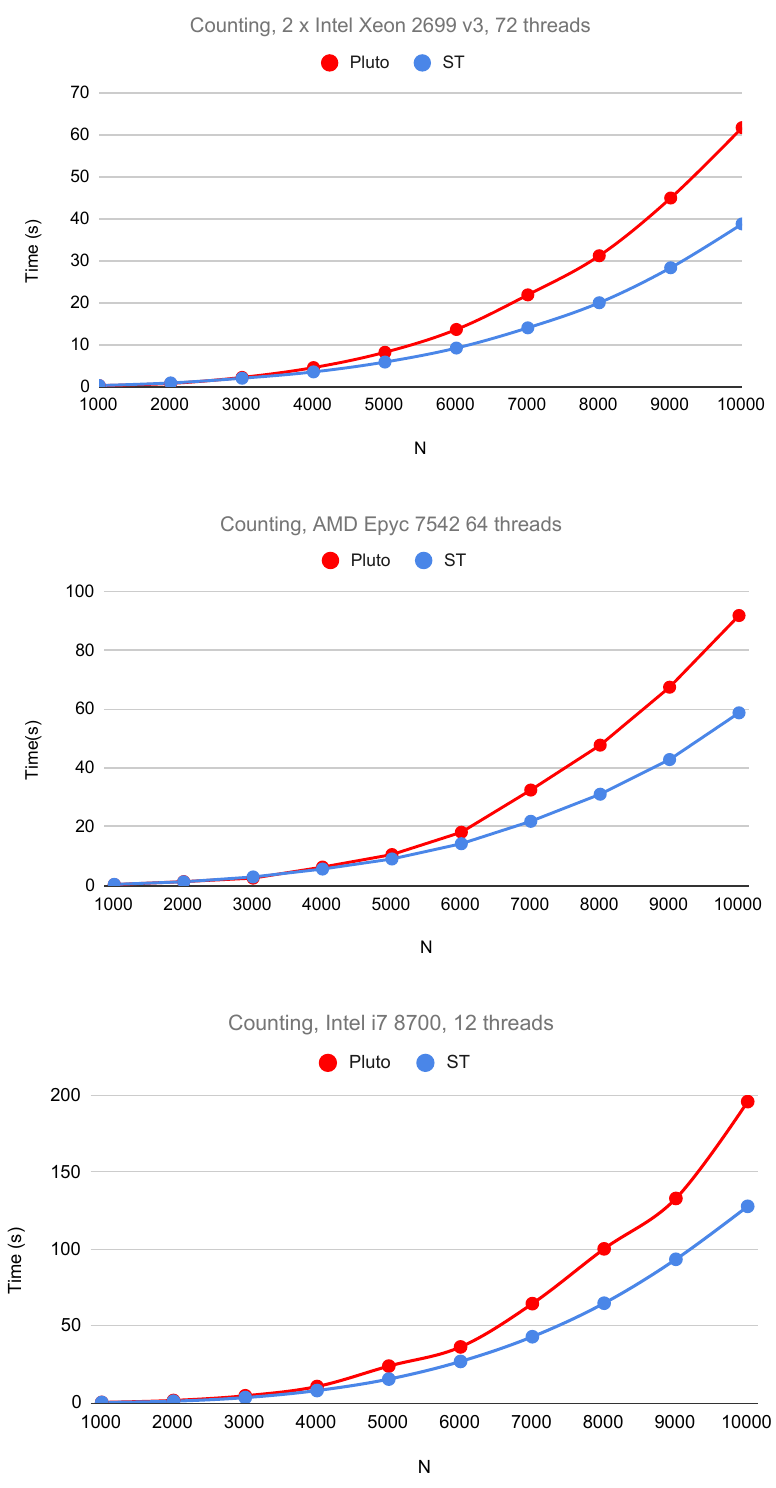
Figure 3. Running times of the parallel tiled Counting implementations generated by applying space-time tiling and